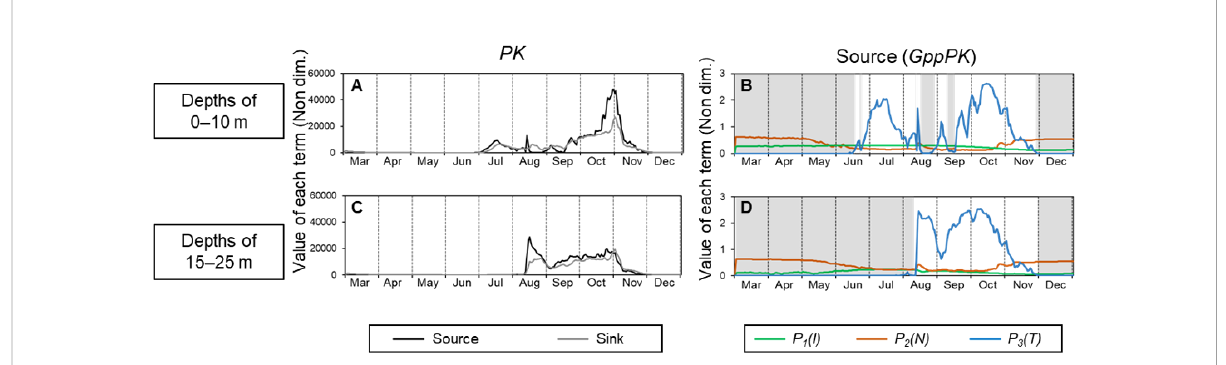
FIGURE 6 Seasonal changes of the values of each term in the equation for PK and GppPK at depth intervals of 1 – 10 m (A, B) and 15 – 25 m (C, D) in 2021. A and C show the source ( GppPK ) and sink (sum of respiration, mortality, extracellular excretion, and grazing) terms in the PK biomass equation (Eq. [1]). B and D show values of P 1 ( I ) , P 2 ( N ) , and P 3 ( T ) in GppPK (Eq. [2]). Gray shading shows the period when P 3 ( T ) was the factor limiting GppPK